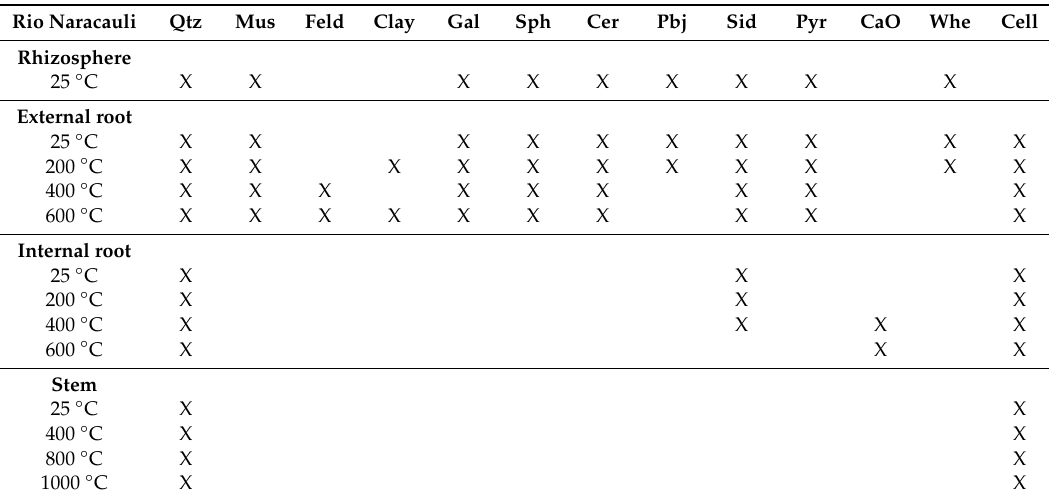
Table 3. Mineral assemblages of samples from Rio Naracauli at the di ff erent temperatures of the heating ramp. Abbreviation are: Qtz, quartz; Mus, muscovite; Feld, feldspars; Clay, clayey minerals; Gal, galena; Sph, sphalerite; Cer, cerussite; Pbj, plumbojarosite; Sid, siderite; Pyr, pyrite; CaO, calcium oxide; Whe, whewellite; Cell, cellulose. Rio